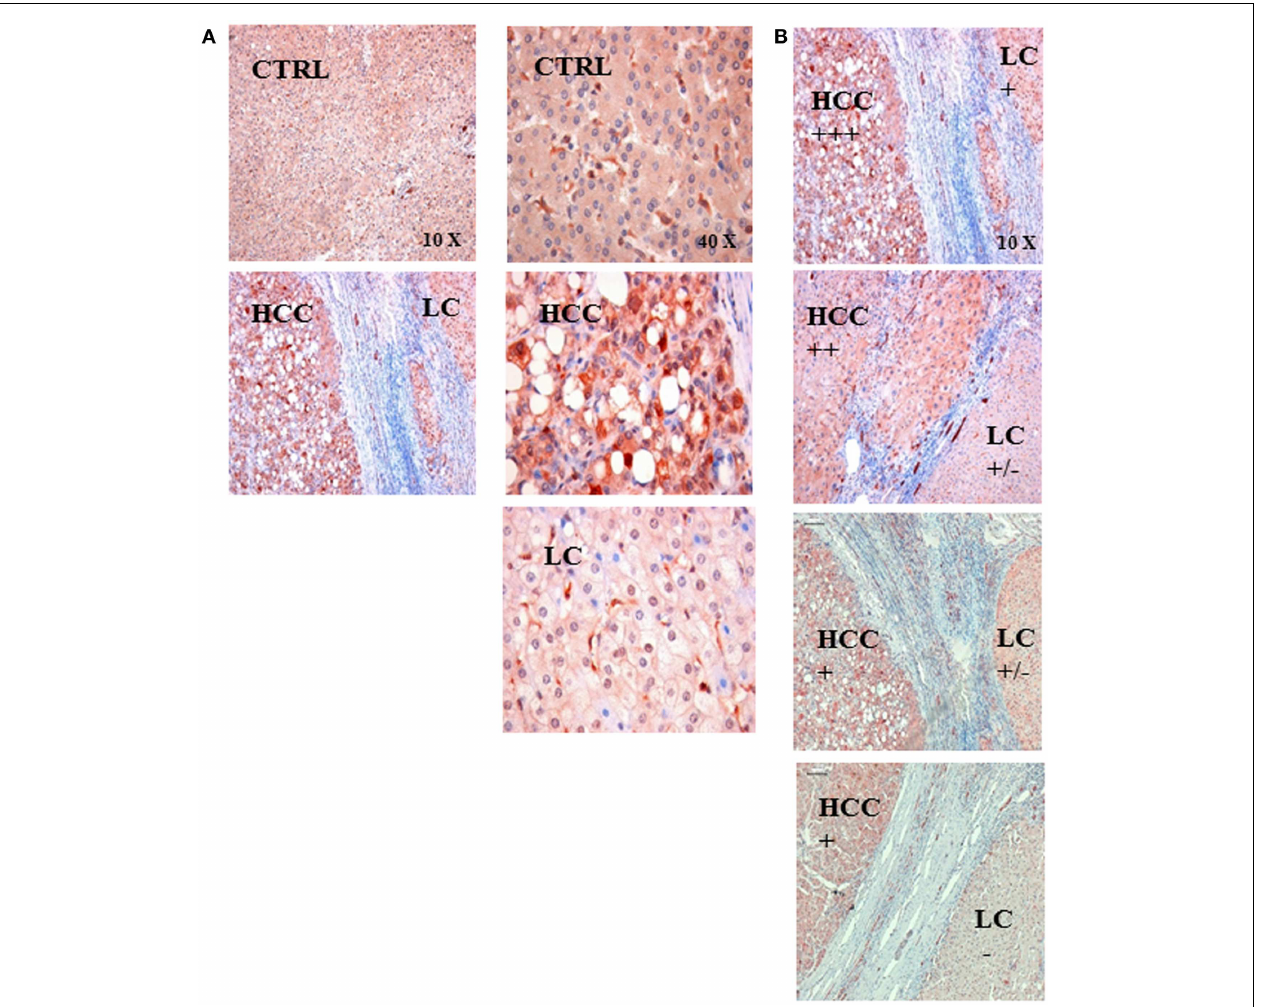
FIGURE 2 | (A) Representative immunohistochemical images of the HSP70 staining in control liver tissue (CTRL) and in the tissue of a patient with hepatocellular carcinoma (HCC) with an underlying liver cirrhosis (LC).The HSP70 staining intensity was stronger in HCC tissue compared to that of control liver tissue (CTRL) and in areas with liver cirrhosis (LC); left panel 10 × magnification, right panel 40 × magnification.